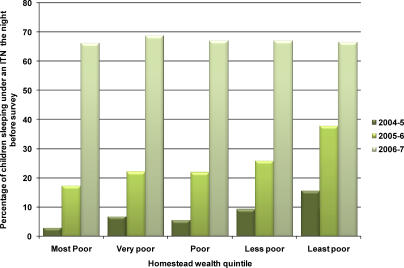
Proportion of Children Sleeping under an ITN in 2004/5, 2005/6, and 2006/7 in Homesteads of Different Wealth Status in Four Districts in Kenya